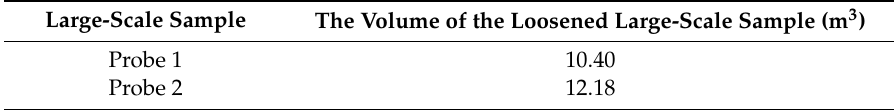
Figure 13. Digital data processing and calculation of the volume of loosened raw material from the large-scale samples Probe 1 and Probe 2 at the LBK Perlit site. Table 5. Volumes of loosened mineral from large-scale samples Probe 1 and Probe 2, determined geodetically from TLS.